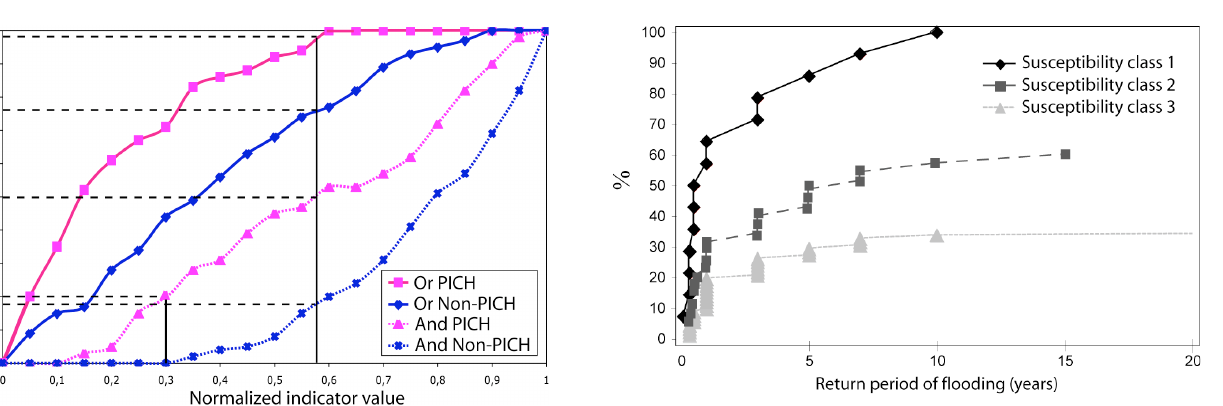
Fig. 6. Cumulative distributions of the combined index value for Figure 6. Cumulative distributions of the combined index value for the two tested connectors the two tested connectors for the PICH and Non-PICH sets in the for the PICH and Non-PICH sets in the four calibration areas four calibration areas.